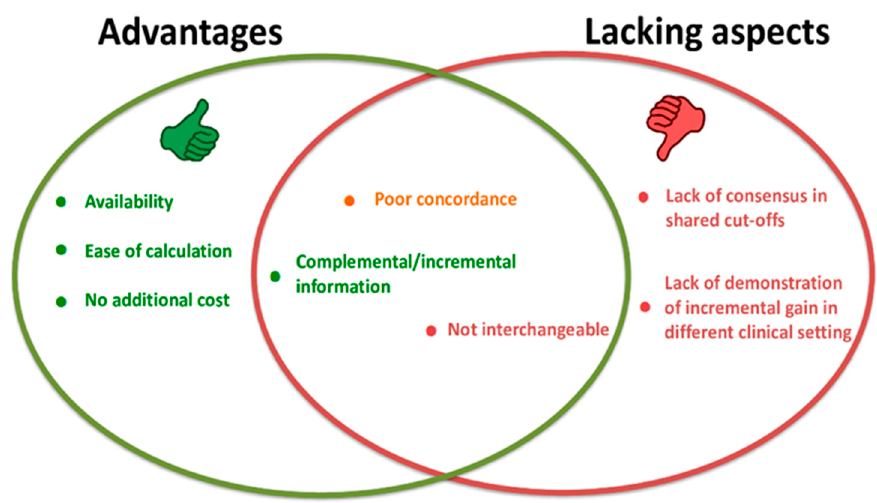
Figure 1. Main advantages/disadvantages of the new proposed non-invasive lipid indices.